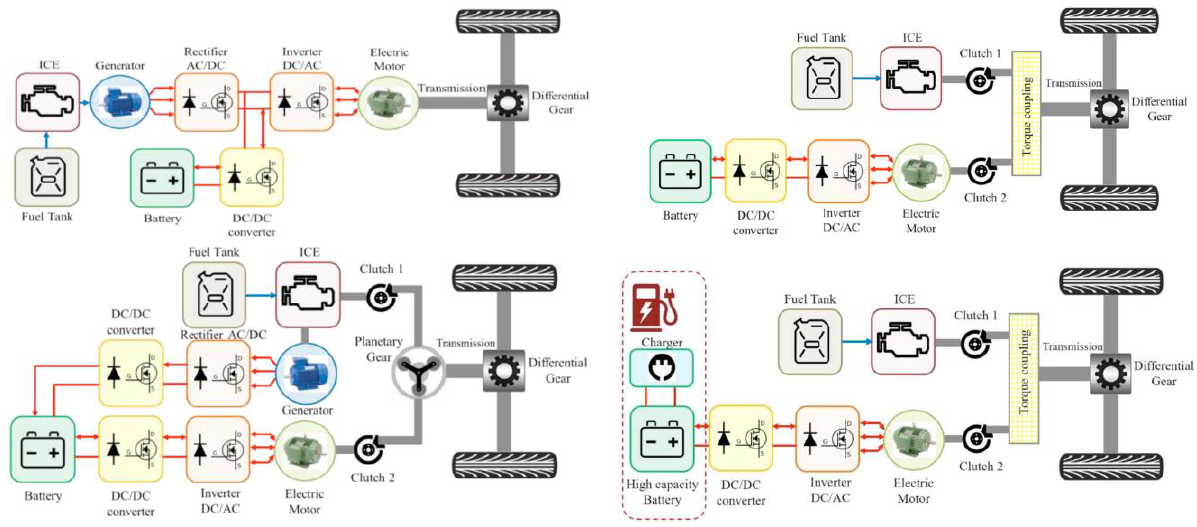
Fig. 1. Types of configuration of hybrid and hybrid plug-in propulsions [17]